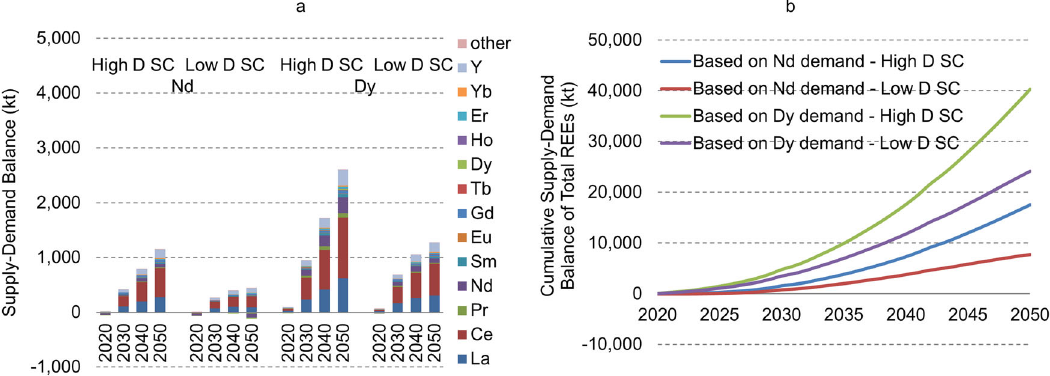
Fig. 3 REEs supply-demand balance. a Annual supply-demand balance of individual REEs; and b Cumulative supply-demand balance of total REEs as a result of Nd and Dy demand in WP and EVs in the high and low demand